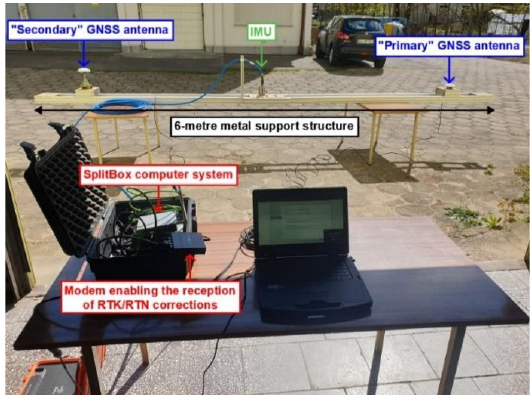
Figure 2. The arrangement of the GNSS/INS system on the metal support structure. In the next stage, it was possible to perform the GNSS/INS system calibration in mo- tion. To this end, a Melex electric vehicle was used, on which a metal support structure was installed along with the tested inertial navigation system (Figure 3a). Before starting the calibration of the inertial navigation system, several parameters of the GNSS/INS sys- tem had to be set in the sbgCenter software, including, inter alia, the movement profile. Given the nature of the railway measurements , it was decided to select the “ Automotive ” mode dedicated to vehicle applications, i.e., those in which there are slight (slow) changes in the movement direction and the object’s velocity is less than 3 m/s. In addition, it was necessary to determine the axis orientation of the GNSS/INS system. A left-handed or- thogonal coordinate system was adopted, whose zero point was present on the IMU’s cover. The axes of the system were oriented in such a way that the x -axis ran towards the front of the Mobile Measurement Platform (MMP), the y -axis was oriented towards the left side of the platform, while the z -axis ran towards the bottom part of the MMP. In order to be able to calibrate the inertial navigation system, it was necessary to determine the geometric relationships between the IMU and two GNSS antennas with an accuracy not worse than 20 cm. After performing the steps described above, the correctness of the per- formed GNSS/INS system configuration can be verified using the sbgCenter software (Figure 3b).